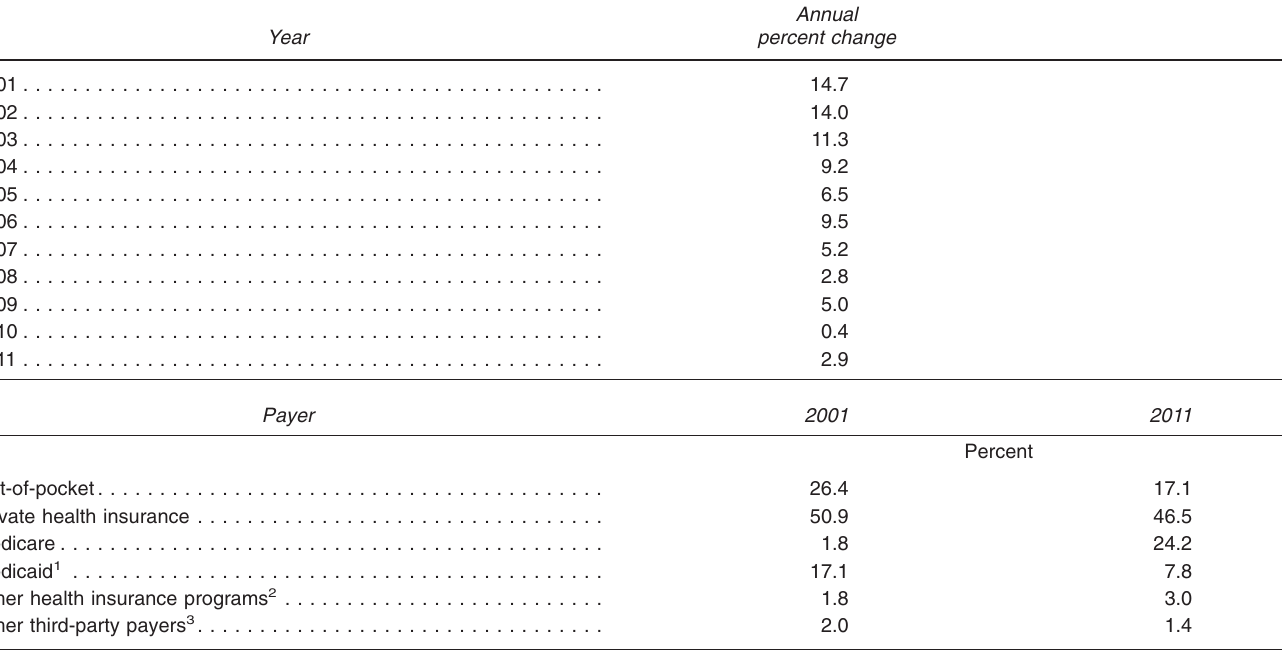
Data table for Figure 29. Retail prescription drug expenditures, annual percent change, and spending by payer: United States,